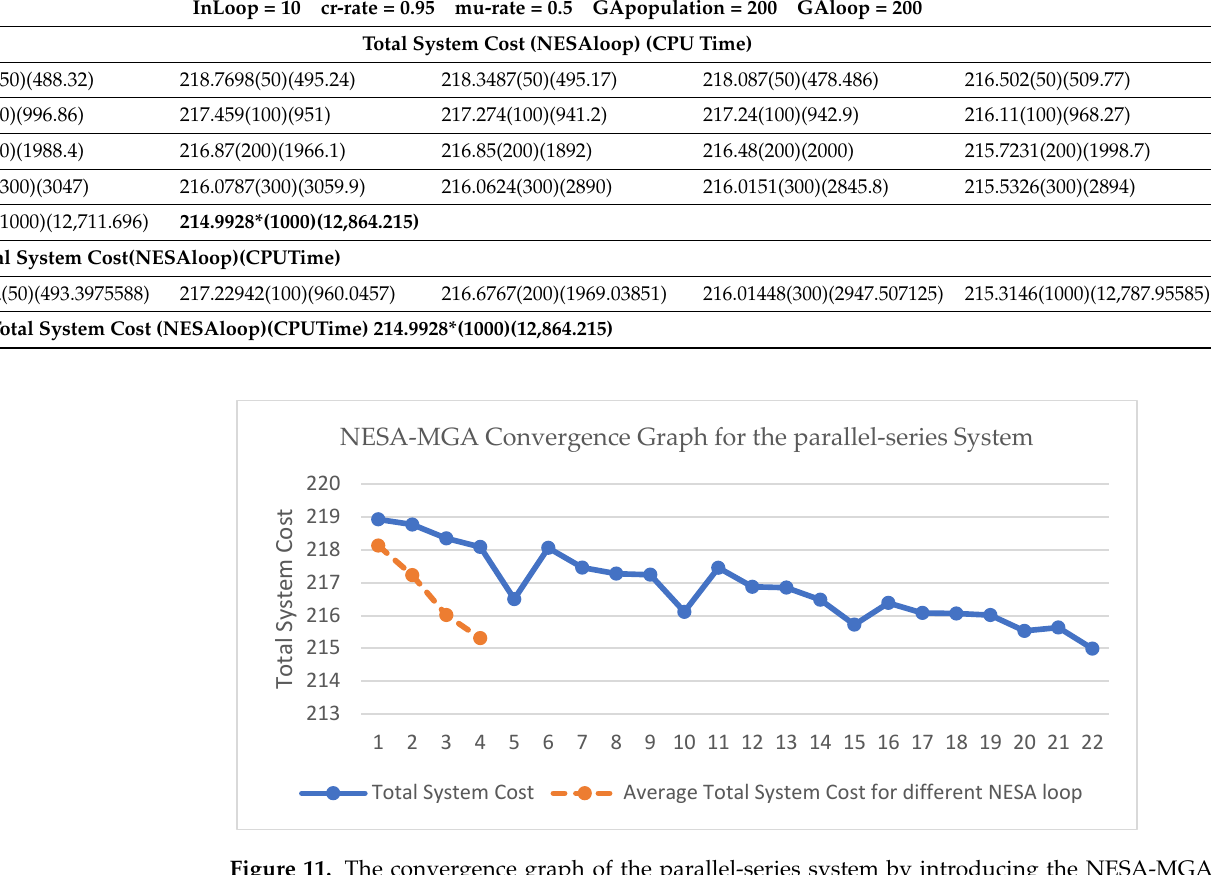
Table 22. Optimal Solutions obtained by NESA–MGA for the parallel-series system.